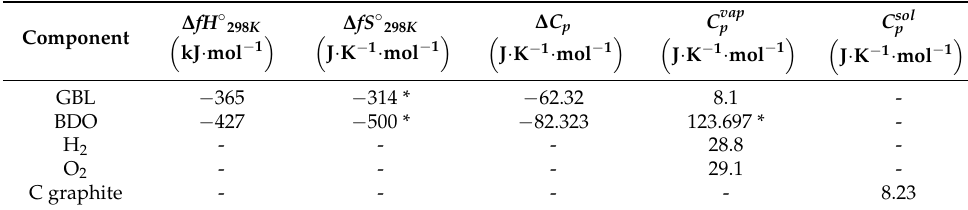
Table 5. Thermodynamic data used for the modeling of the equilibrium constant. Data were extracted from the databases of NIST and